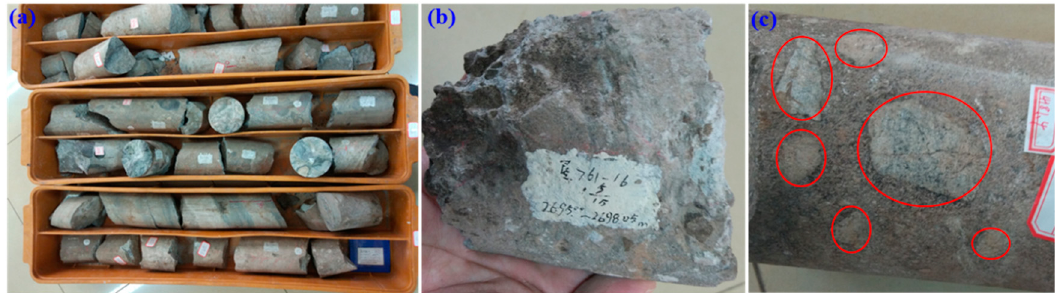
Figure 1. Glutenite cores drilled from a well in Shengli Oilfield: ( a ) Overview of glutenite cores and a more detailed view of the morphology of glutenite cores with ( b ) fine gravel and ( c ) coarse gravel.